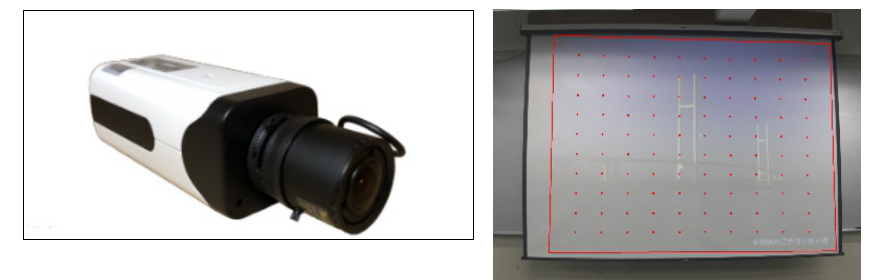
Figure 7. Image luminance meter and measuring point setting. Table 1. The statistical results of the image luminance meter calculating the luminance level.